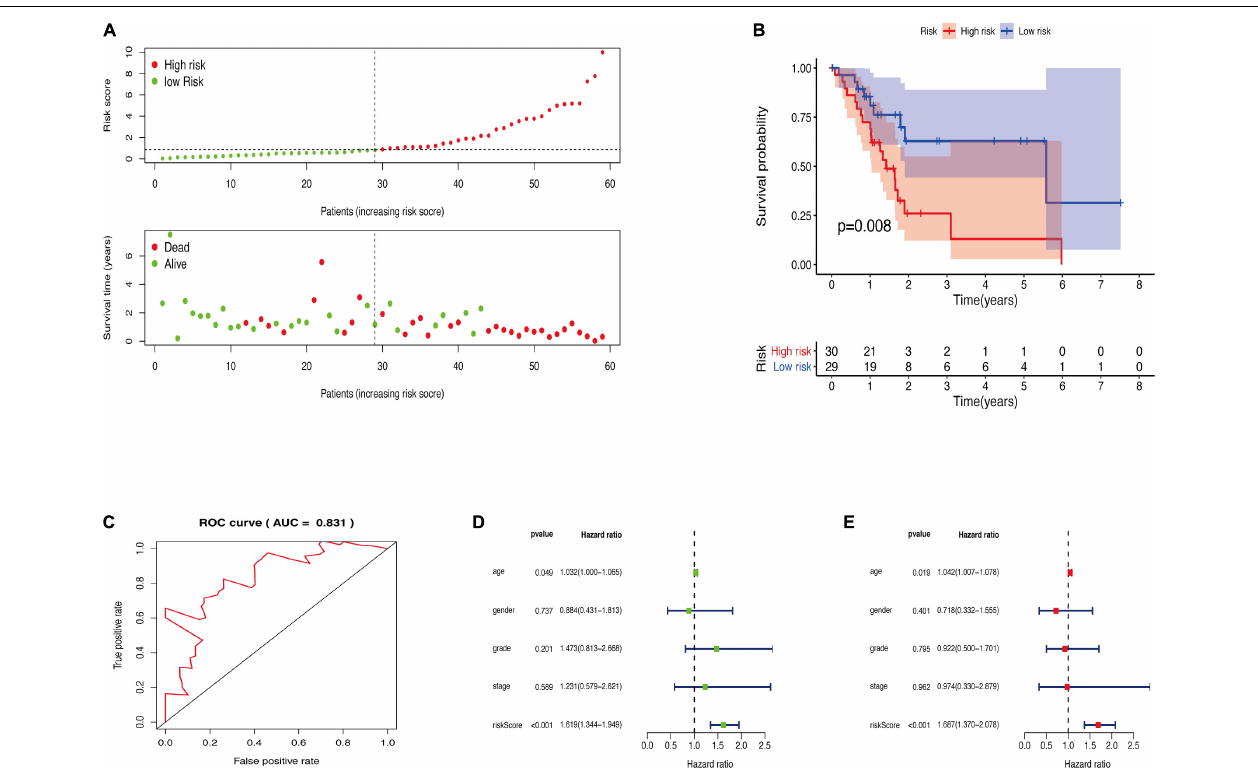
FIGURE 4 | (A) The model divides the testing set patients into low-risk or high-risk groups. (B) Kaplan Meier curve between high and low risk groups. (C) Time-dependent ROC curve for GRGs in the testing cohort. (D) Testing set single factor Cox regression analysis forest map. (E) Testing set multivariate Cox regression analysis forest map.